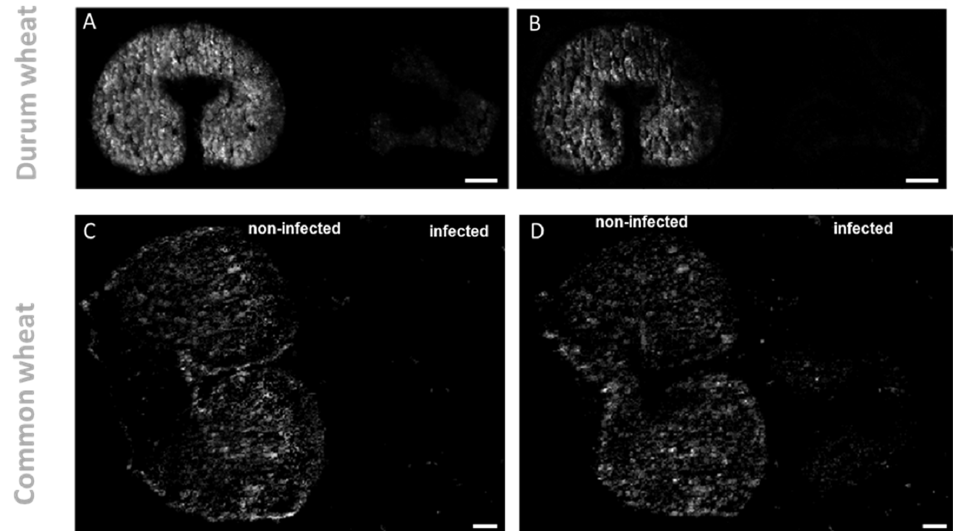
Figure 3. Spatial distribution of galactolipid in durum ( A , B ) and common wheat ( C , D ) cross-sections. ( A , C ). DGDG (36:4) [M + K] + m/z 979.5735 and ( B , D ) MGDG(36:4) [M + K] ⁺ m/z 817.5227 were found exclusively in the non-infected seeds. MS images were generated with ( A , B ) 336 × 138 pixels; 20 µm pixel size; m/z bin width: ±5 ppm; scale bars: 500 µm; ( C , D ) 300 × 220 pixels; 15 µm pixel size; m/z bin width: ±5 ppm; scale bars: 200 µm. The activity of galactolipases will lead to the accumulation of galactolipid building- block, namely fatty acids and the disaccharide headgroup (galactopyranosyl-glucopyra- nosyl) that the plant will re-use for further biochemical reaction. As reported in Figure S4, we observed the accumulation of trisaccharides (galactopyranosyl-galactopyranosyl- arabinose), among other carbohydrates (see Table S1) in the endosperm of infected com- mon and durum wheat kernels.